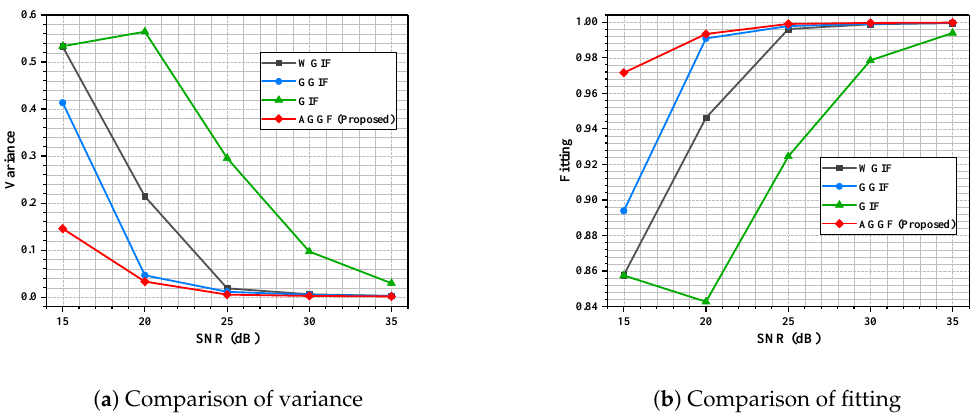
Figure 11. Seabed experiment, f p = 2 GHz; influence of SNR on filtering